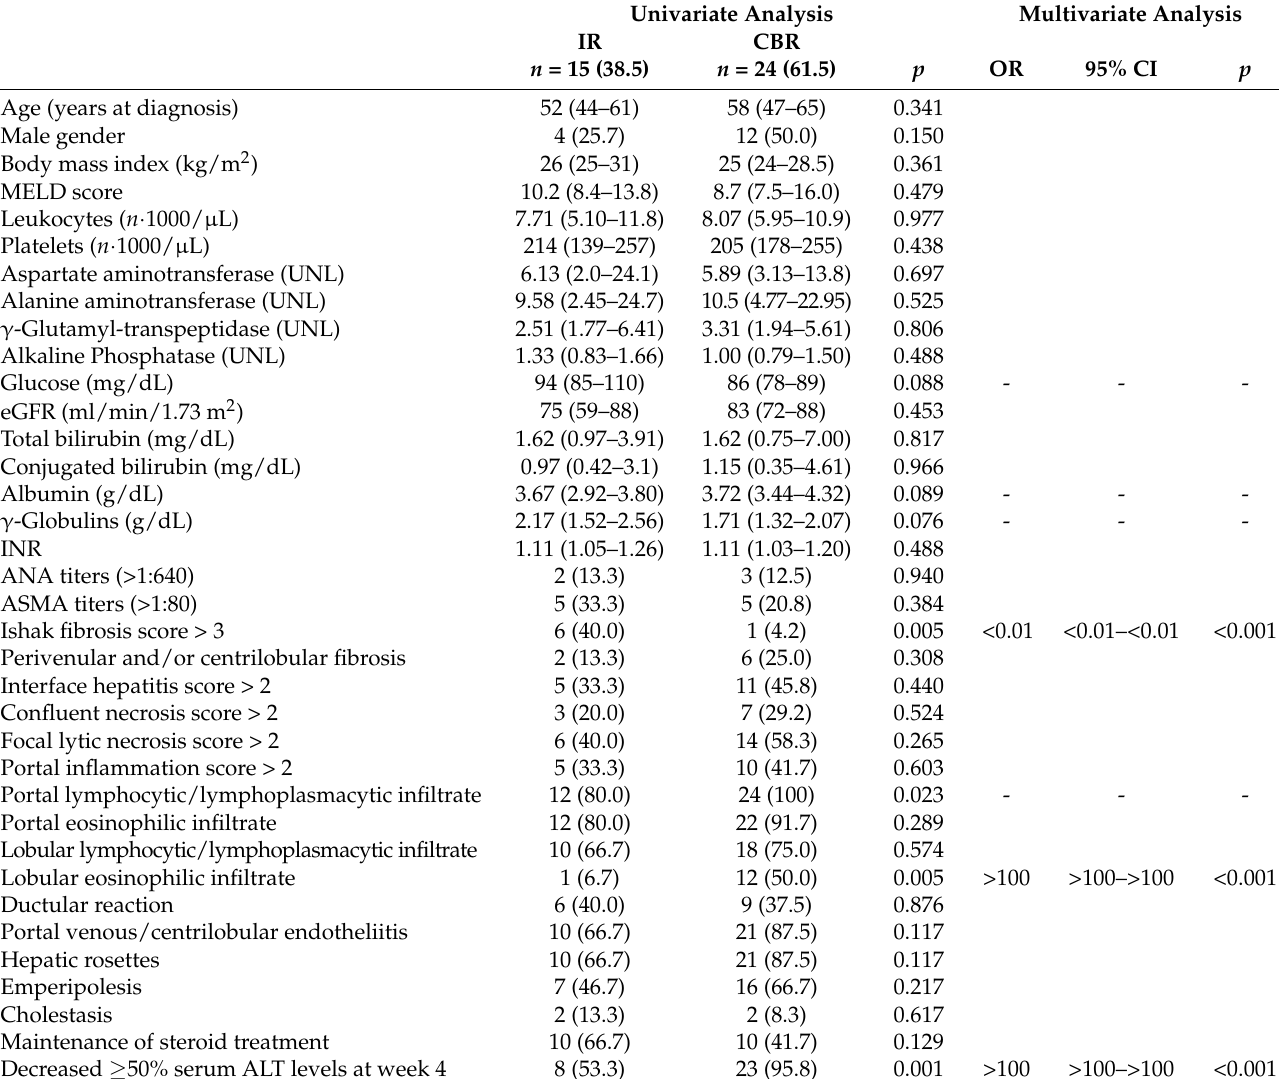
Table 4. Association between baseline demographic, clinical, and histological characteristics of patients ( n = 39) concerning the achievement of complete biochemical response (CBR) or insufficient response (IR), defined as the normalization of serum transaminases and IgG levels below the upper normal limit (UNL) within six months after treatment initiation and as lack of CBR, respectively. Categorical parameters are presented as frequencies (%), and the Pearson chi-squared test was used for statistical comparisons. Continuous variables are presented as medians (interquartile range), and the rank-sum test (Mann-Whitney) was used for statistical comparisons. Stepwise regression with a forward approach was used to discriminate independent predictive variables associated with the achievement of CBR. Univariate Analysis Multivariate